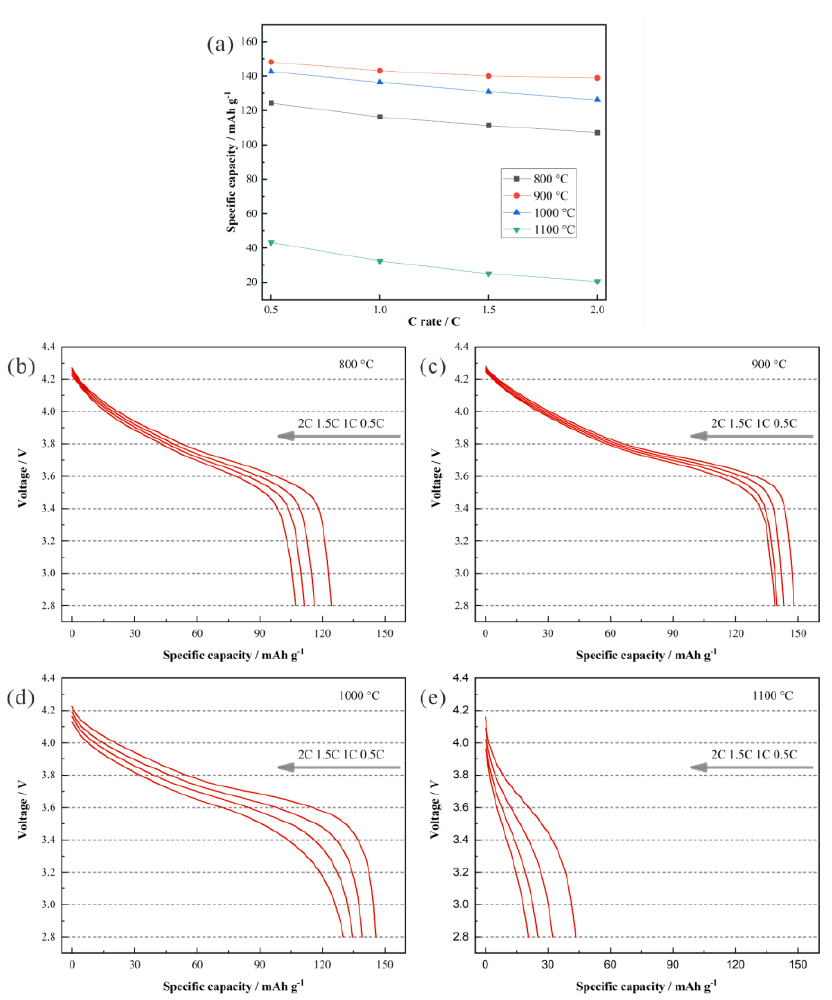
Figure 7. ( a ) Rate performances of the half cells with LiNi 0.5 Co 0.2 Mn 0.3 O 2 synthesized at different temperatures and the corresponding discharge curves at the rates of ( b ) 0.5 C, ( c ) 1 C, ( d ) 1.5 C, and ( e ) 2 C.